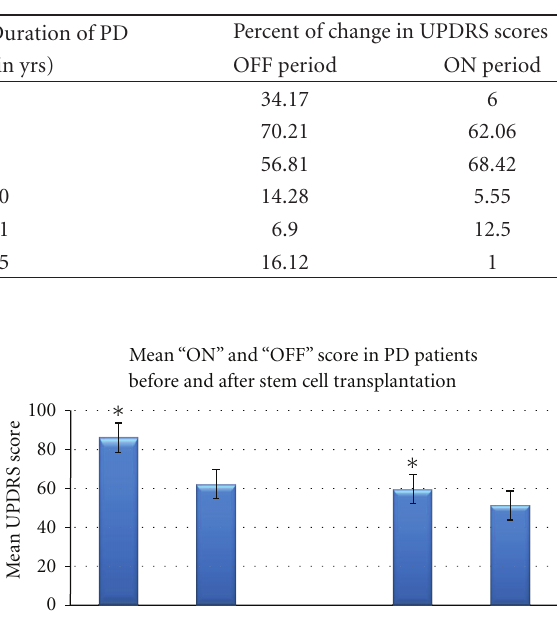
Table 2: Shows the improvement in UPDRS scores for PD patients before and after stem cell transplantation.